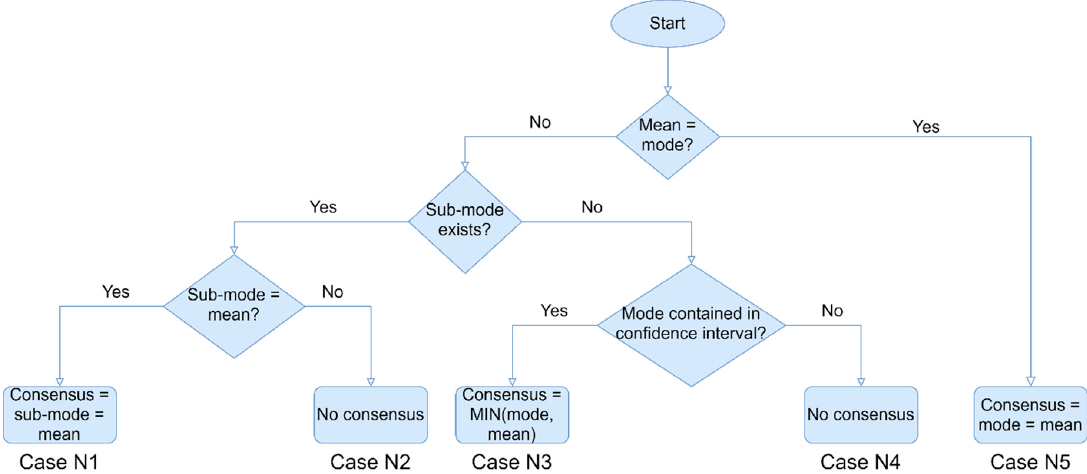
Figure 2. Quantitative analysis decision tree.